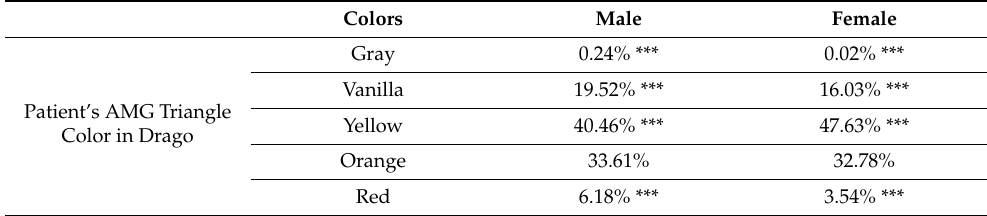
Table 8. Colors of the AMG triangle of persons over 65 years of age living alone based on sex. Basic Health Areas of Gran Canaria. 2018–2020. (Percentages—%). Colors Male Female Gray 0.24% *** Patient’s AMG Triangle Color in Drago